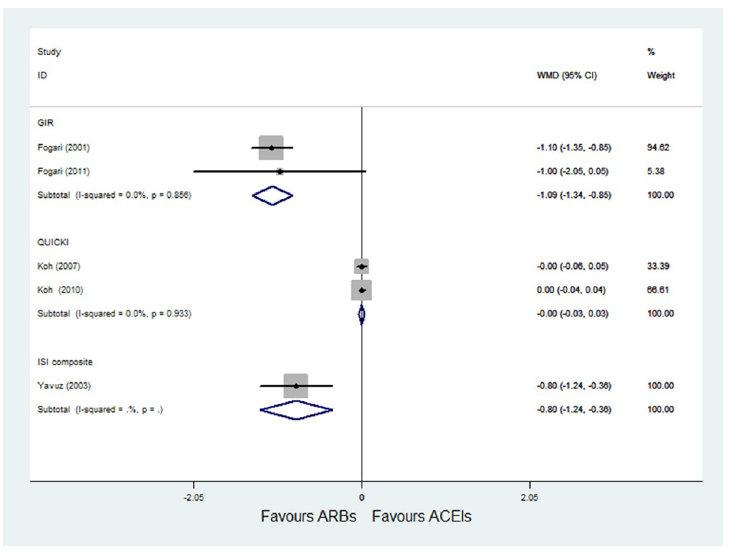
Fig 3. Effect of ARBs versus ACE inhibitors on GIR, QUICKI, and ISI composite.